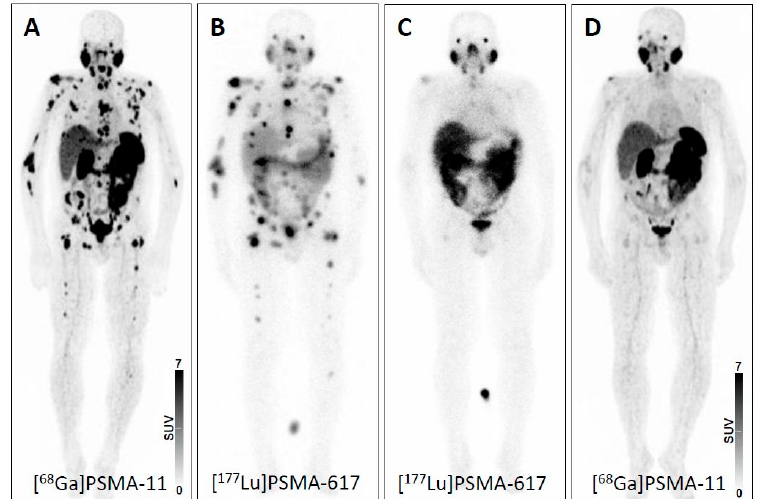
Figure 1. Theranostic concept in prostate carcinoma using prostate-membrane specific antigen (PSMA)-directed imaging and therapy. ( A ) PSMA-targeted positron emission tomography (PET) imaging before initiation of PSMA-targeted therapy showing widespread metastatic disease. Post-therapeutic scintigraphic scan after ( B ) one and ( C ) two cycles of PSMA-targeted therapy. ( D ) PSMA-targeted PET imaging after two cycles of therapy demonstrating high therapeutic e ffi cacy and near-complete remission. Response was further corroborated by a decline in prostate specific antigen (PSA) level from 396.0 ng / mL to 7.35 ng / mL. PSMA: prostate-specific membrane antigen.